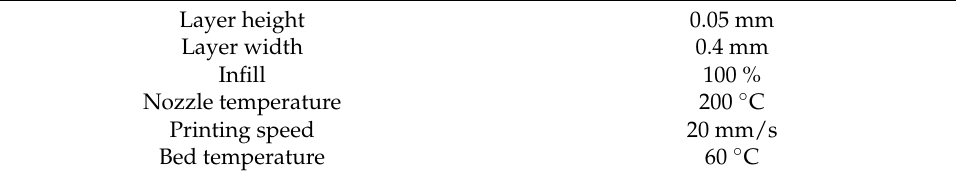
Table 2. Processing parameters for tensile bars in the FFF process.